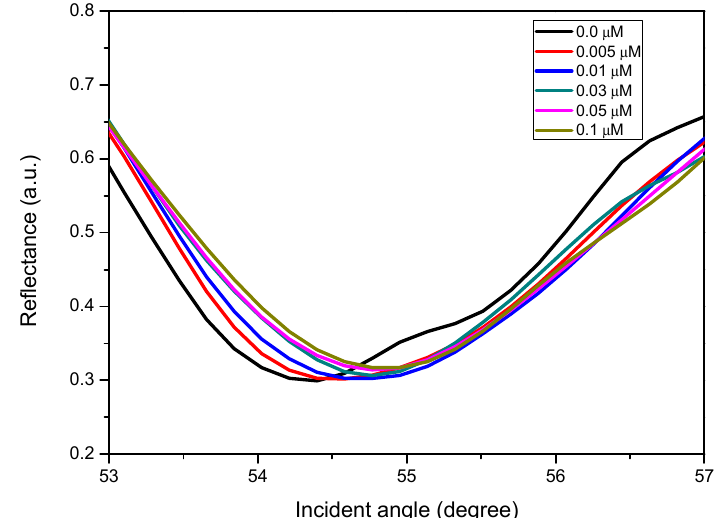
Figure 9. SPR curves for CTA-NCC/CGQD nanocomposite thin film for glucose solution with different concentrations (0.0–0.1 μ M).